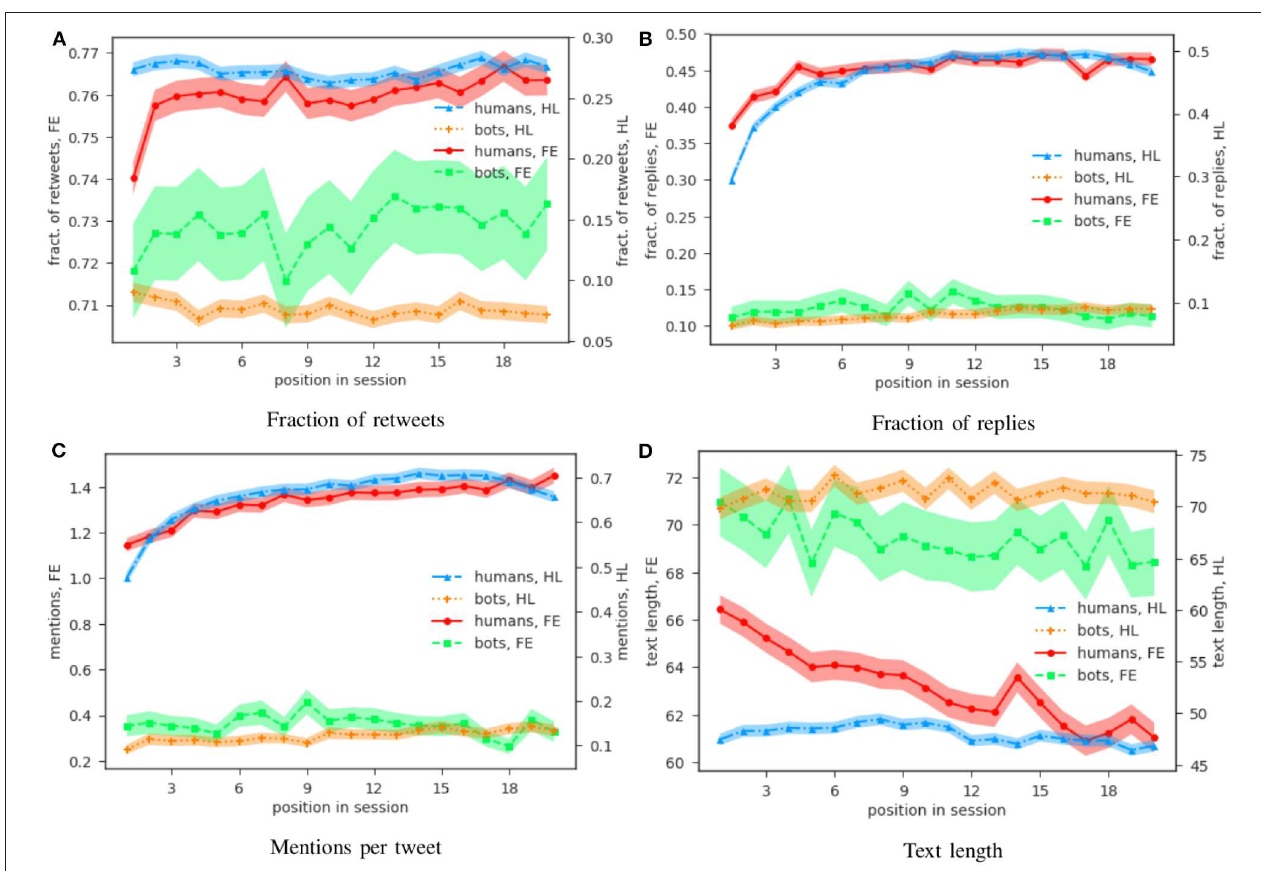
FIGURE 4 | Trend of four different behavioral measures over the course of an online session. We plot, as a function of the tweet’s position in its session, four behavioral indicators extracted from the tweets: the fraction of retweets, the fraction of replies, the average number of mentions per tweet, and the average text length (in characters). All the sessions considered here contain a similar number of posts (20–25) to limit biases due to the different behavioral patterns adopted by users in sessions of different length [10]. The number of sessions considered is thus 1,500 for the bots and 13 K for the humans in the FE dataset, and 1,300 for the bots and 5,800 for the humans in the HL dataset. In all quantities except (A) , retweets have been excluded from the analysis, as we are only interested in original content produced by the users. The shaded area corresponds to one SEM ( standard error of the mean ), calculated separately for each point. We use different scales for the two datasets (FE on the left axis, HL on the right one) to facilitate the comparison within account types. For all measures, not only the datapoints are well separated between the two categories of users (within (within one SEM), but humans also show temporal trends which are not observed in bots. In particular: considering the fraction of retweets, shown in (A) , values are higher for human users with respect to bots over all the course of a session; in the FE dataset humans also show an increase in their value, faster in the beginning (first 2–3 tweets), then slower, but still present during all the first 20 tweets. The situation is similar in the case of replies (B) , where humans from both datasets show a similar increase over the first 5–6 tweets. Human users also use more mentions (C) , with a roughly steady increase over the course of a session. As for the average length of the tweets (D) , a decrease is evident for humans in FE, who also post shorter tweets with respect to their automated counterparts. In all the four measures considered, no clear trend emerges for the case of